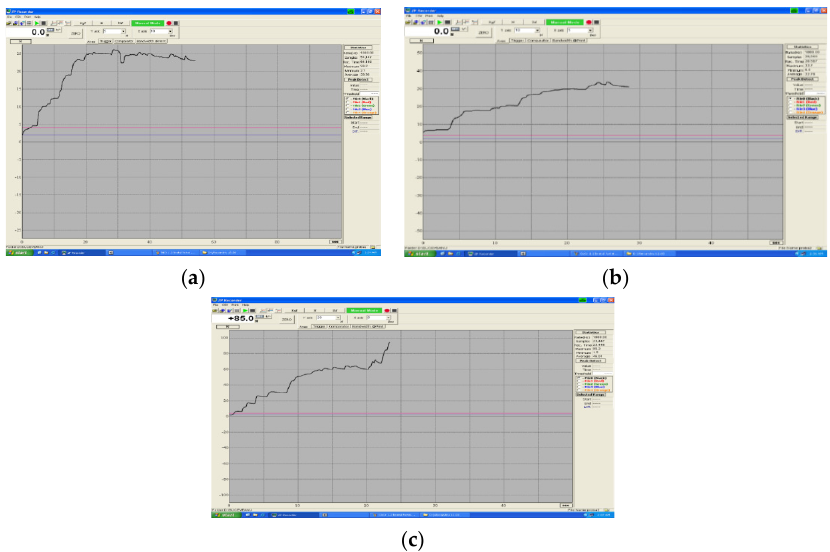
Figure 12. ( a – c ) Evolution of Co-Cr arc forces, diameter 1.2 mm.